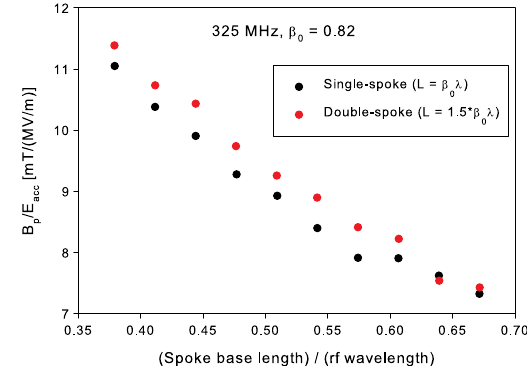
FIG. 3. Dependence of the normalized magnetic field on the spoke base length for a single- and double-spoke cavity with the same spoke and end-cap geometries.